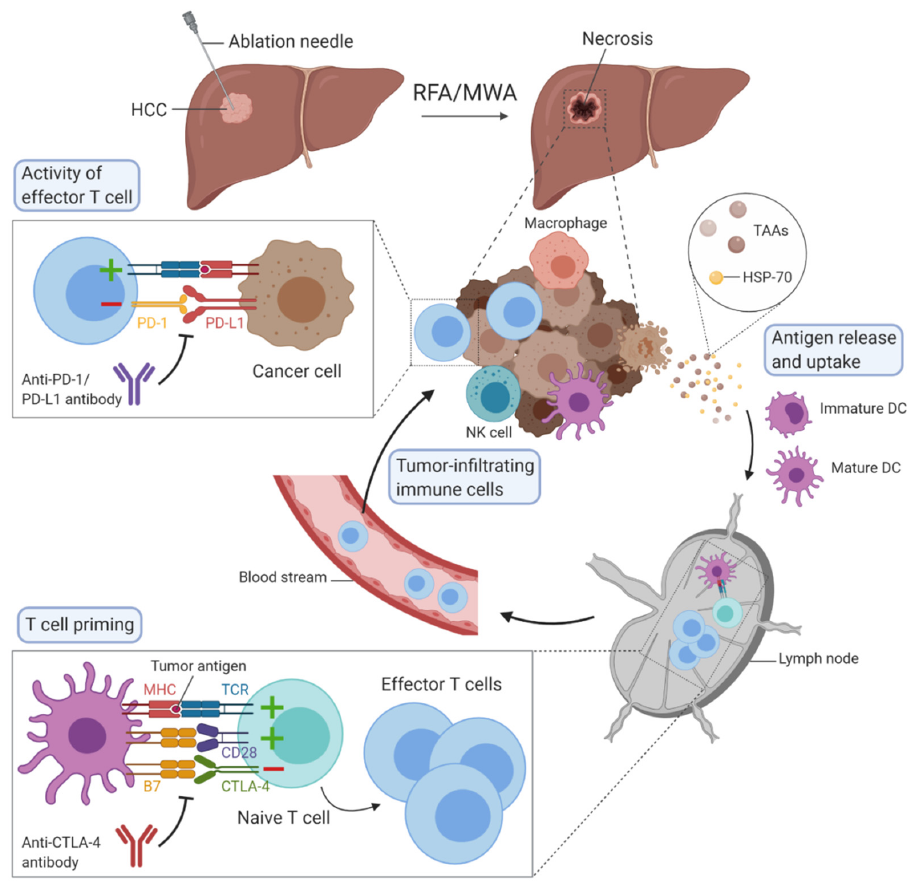
Figure 1. Overview of the possible mechanisms of immunomodulation induced by radiofrequency ablation (RFA) or microwave ablation (MWA) in hepatocellular carcinoma. The figure was created with BioRender.